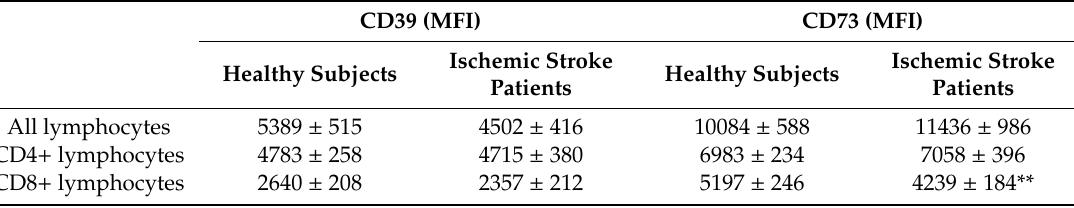
Table 4. Expression level of both CD39 and CD73 ectonucleotidases in lymphocytes from healthy subjects (n = 20) and ischemic stroke patients (n = 21). Data are reported as median fluorescence intensity (MFI) ± SEM. Non-parametric two-tailed Mann–Whitney U test was used to test for significance; ** p <